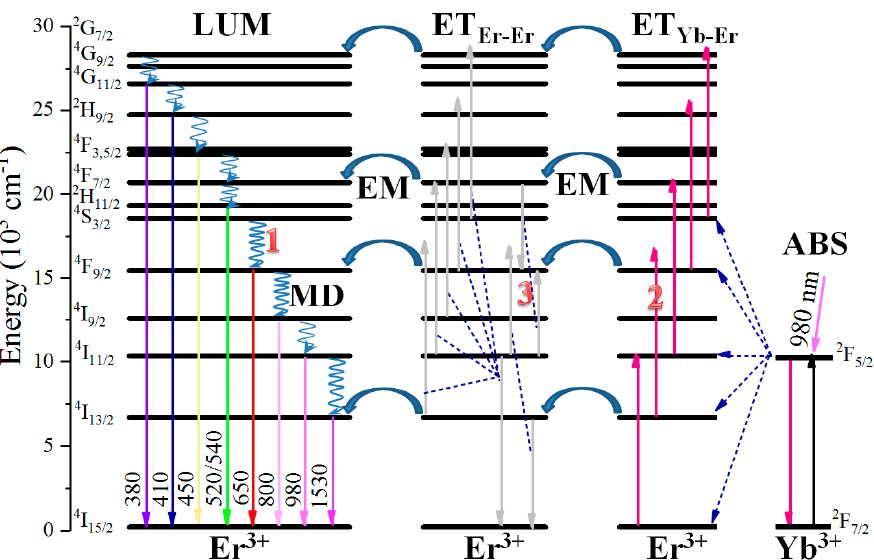
Figure 1. Diagram of Yb 3+ and Er 3+ energy levels with the main possible pathways involved in the Er 3+ luminescence processes. ABS, absorption; ET Yb-Er , ET from Yb 3+ to Er 3+ ; EM, energy migration between neighboring Er 3+ ; ET Er-Er , ET within the levels of the same Er 3+ ion; MD, multiphonon-assisted decay; LUM, luminescence.